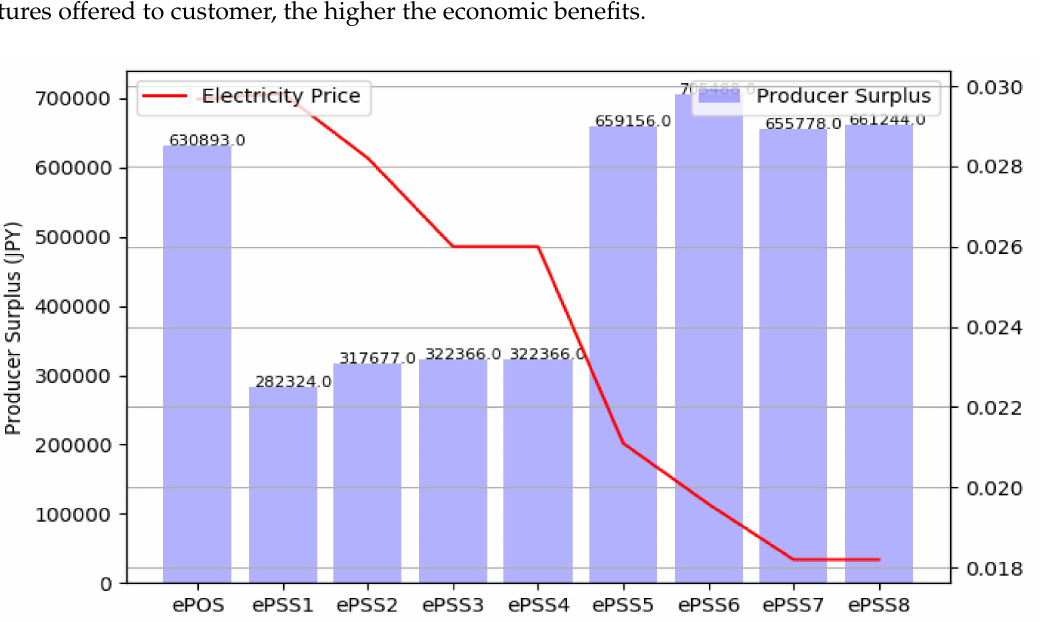
Figure 14. Producer Economic Benefit